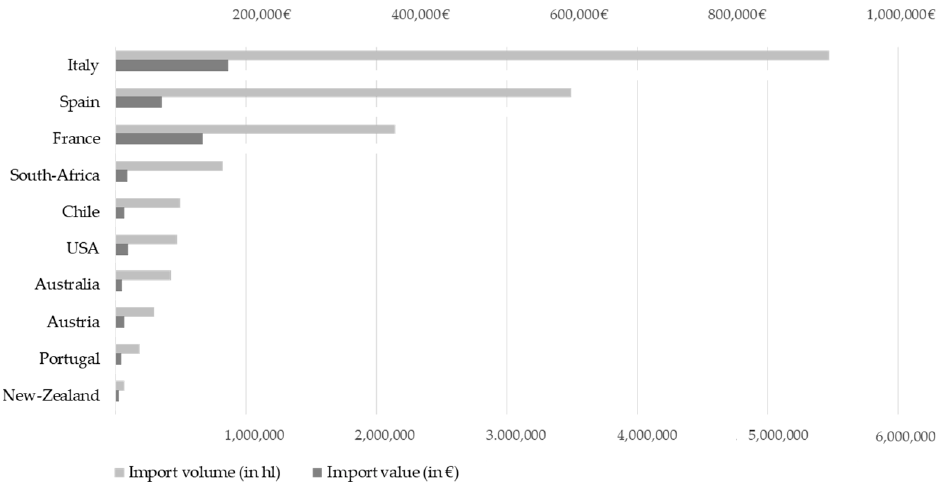
Figure 12. Origination of imported wines (2016) [55].